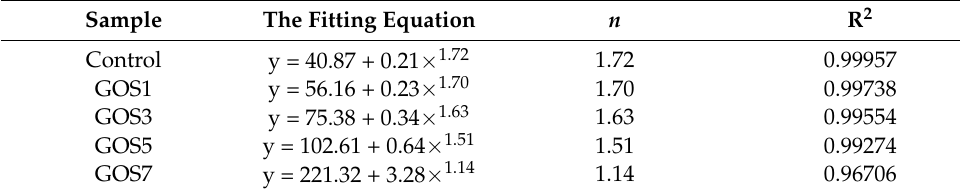
Table 4. The fitting curve equation of the cement paste obtained by H-B fitting.